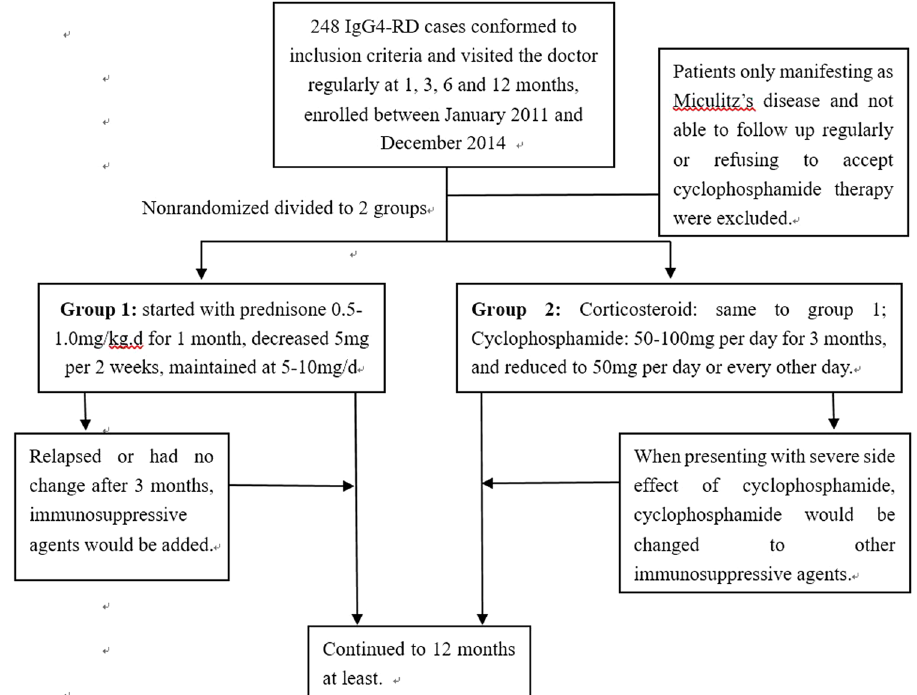
Figure 1. Management for IgG4-RD patients enrolled in this